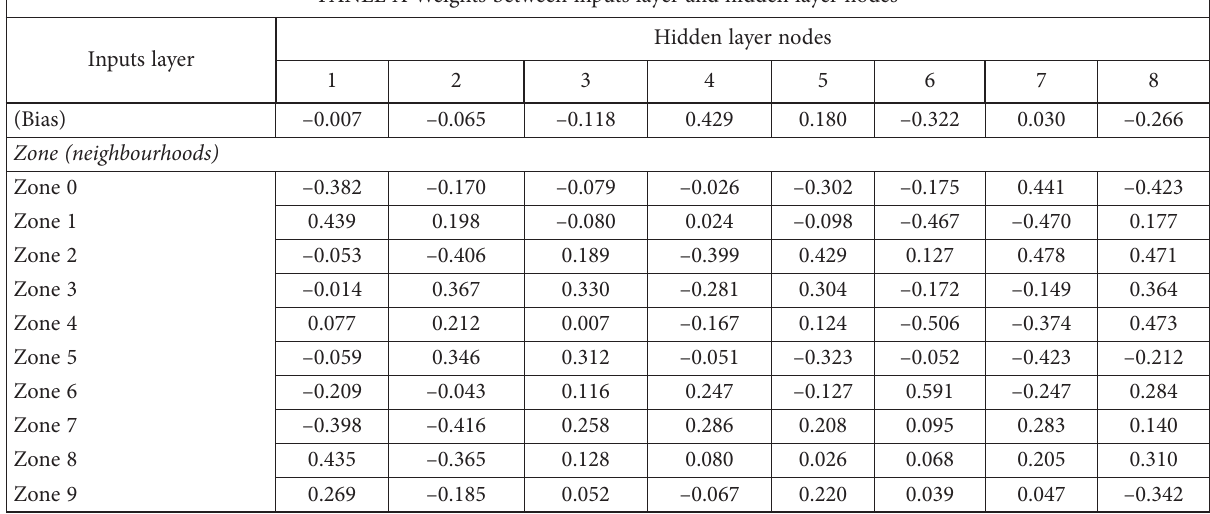
Table 8. ANN connection weights between